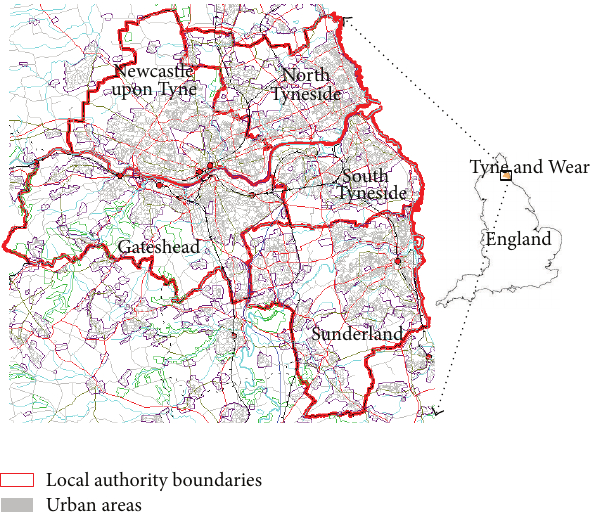
Figure 1: Location of the Tyne and Wear region.